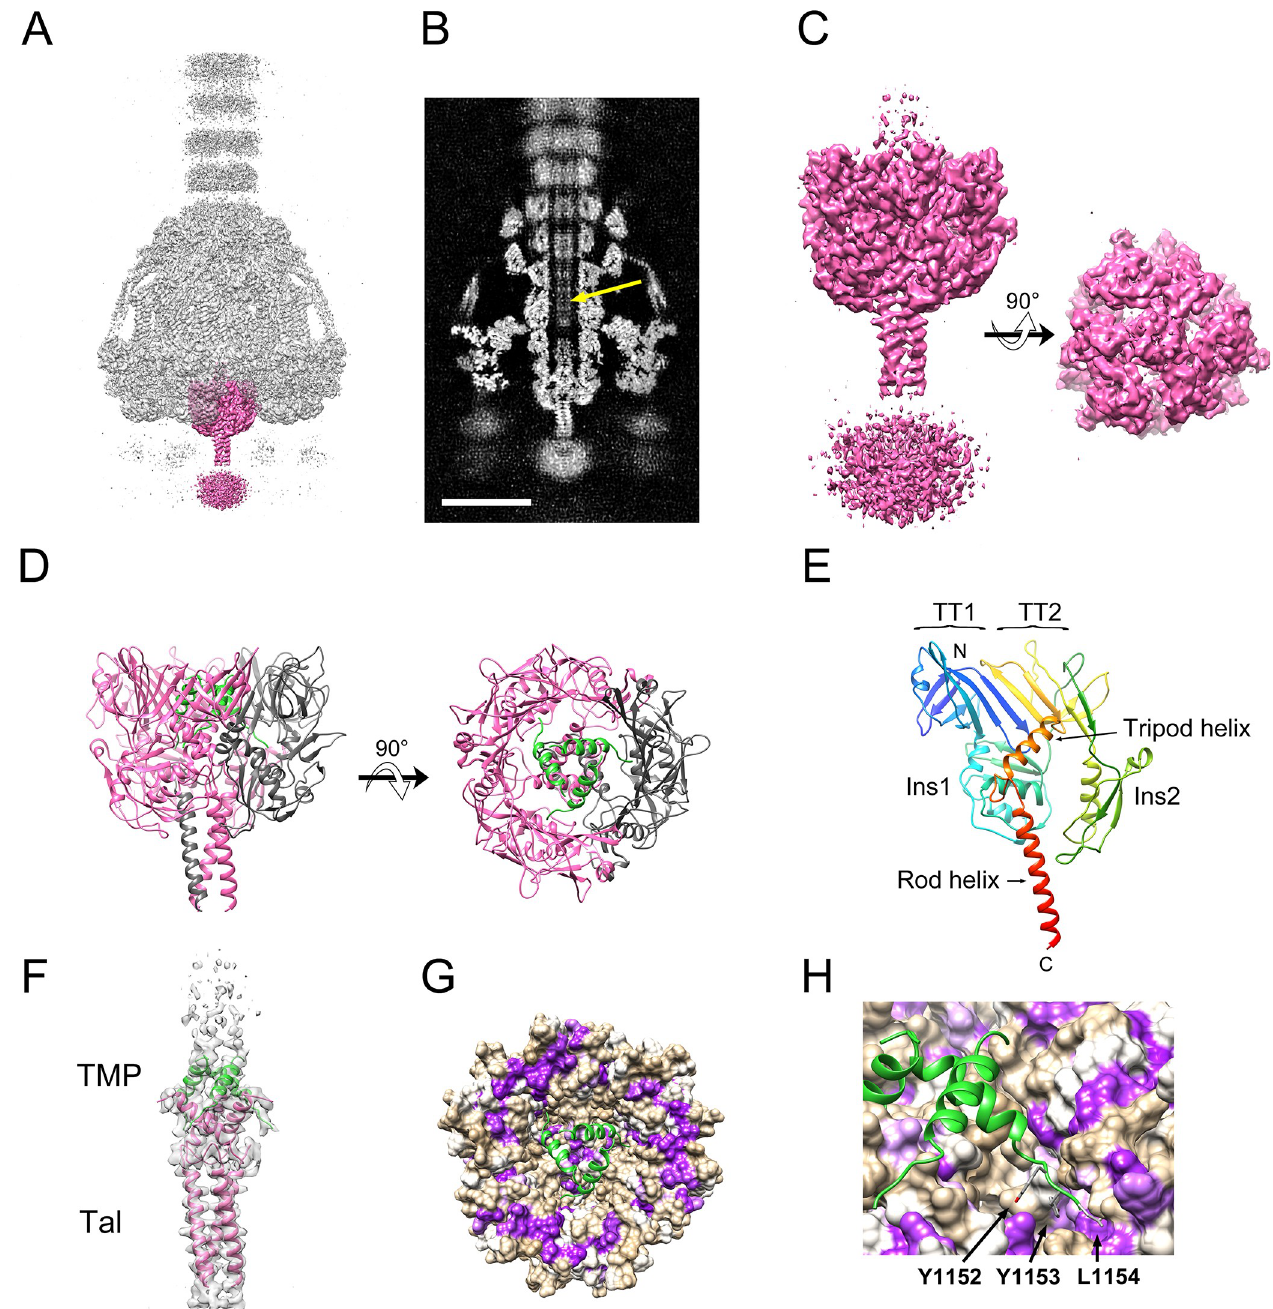
Fig 4. The baseplate tip. (A) Isosurface representation of the C3 symmetric baseplate reconstruction at 4.5 σ density cutoff. The density corresponding to the Tal trimer is shown in pink, with the rest of the reconstruction in transparent gray. (B) Central section through C3 reconstruction (gray scale). Density inside the lumen presumably corresponding to TMP is indicated with the yellow arrow. Scale bar = 100 Å . (C) The Tal density alone, viewed from the side and bottom. The disordered density at the bottom in the side view is assumed to be the Tal CTD and was removed from the bottom view for clarity. (D) Ribbon representation of the atomic model of Tal viewed from the side and bottom. One subunit is colored dark gray. The TMP model is shown in green. (E) Tal subunit, colored in rainbow colors from blue (N-terminus) to red (C-terminus). Relevant structural elements are labeled. (F) Density corresponding to the central part of Tal with the atomic models of Tal and TMP shown in pink and green, respectively. (G) View down the axis of the baseplate showing the inside of Tal as a van der Waals surface, colored from hydrophilic (tan) to hydrophobic (purple). TMP is shown in green. (H) Detail of the interaction between the TMP C-terminus and Tal. The three C-terminal residues of TMP (Y1152, Y1153 and L1154) are shown in stick representation.